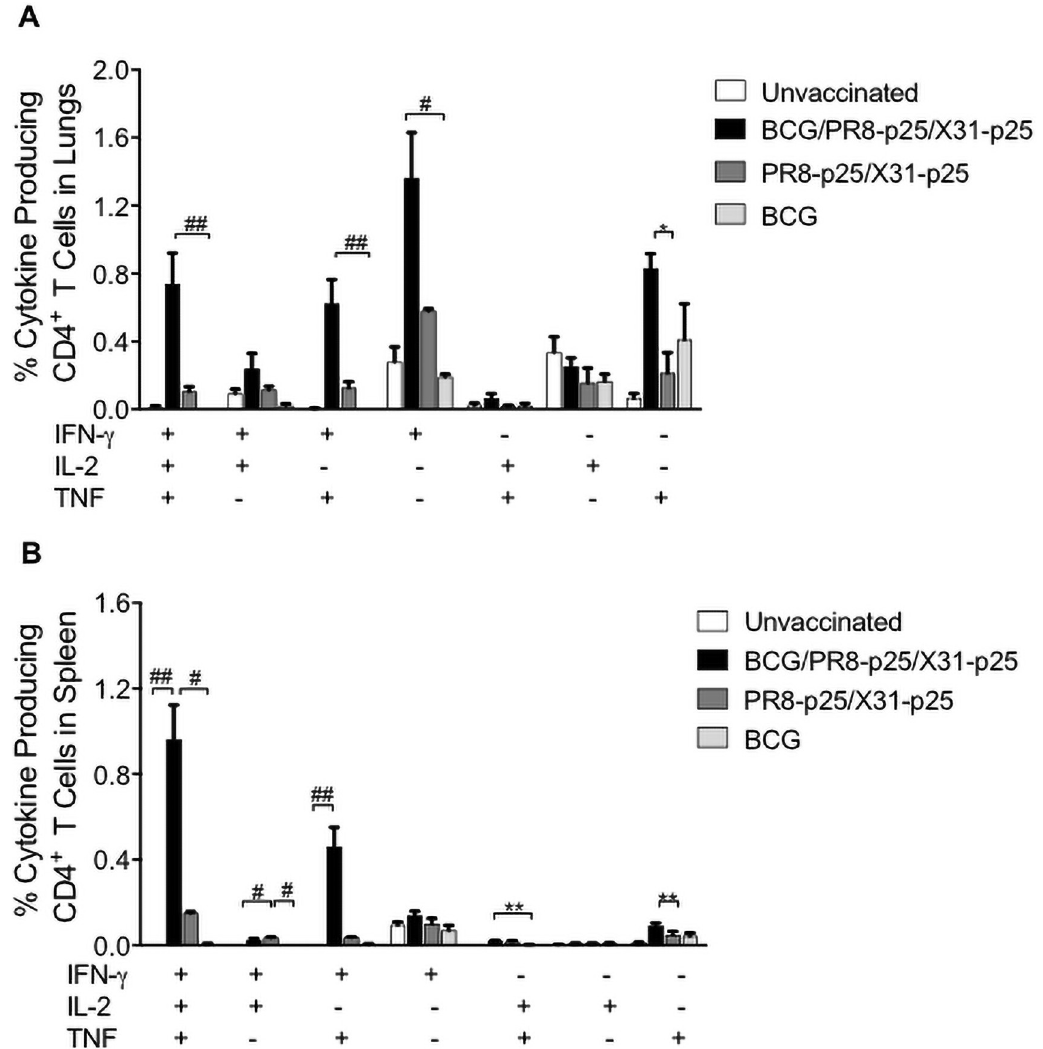
Fig 4. Cytokine production by CD4 + T cells following BCG boosting with rIAVs. C57BL/6 mice (n = 5) were vaccinated with BCG and sequential PR8-p25 and X31-p25 rIAVs as shown in Fig 3A. Four weeks after the last vaccination, lung and spleen cells were stimulated with p25 antigen and cytokine production was analyzed by flow cytometry using Boolean gating. (A) The frequency of p25-specific CD4 + T cells in the lungs and (B) in the spleen producing individual cytokines or combinations of IFN- γ , IL-2, and TNF. Data are the means ± SEM and are representative of two independent experiments. The differences between groups were determined by one-way ANOVA ( � ) or Kruskal-Wallis ( # ) ( � p < 0.05; �� p < 0.01).